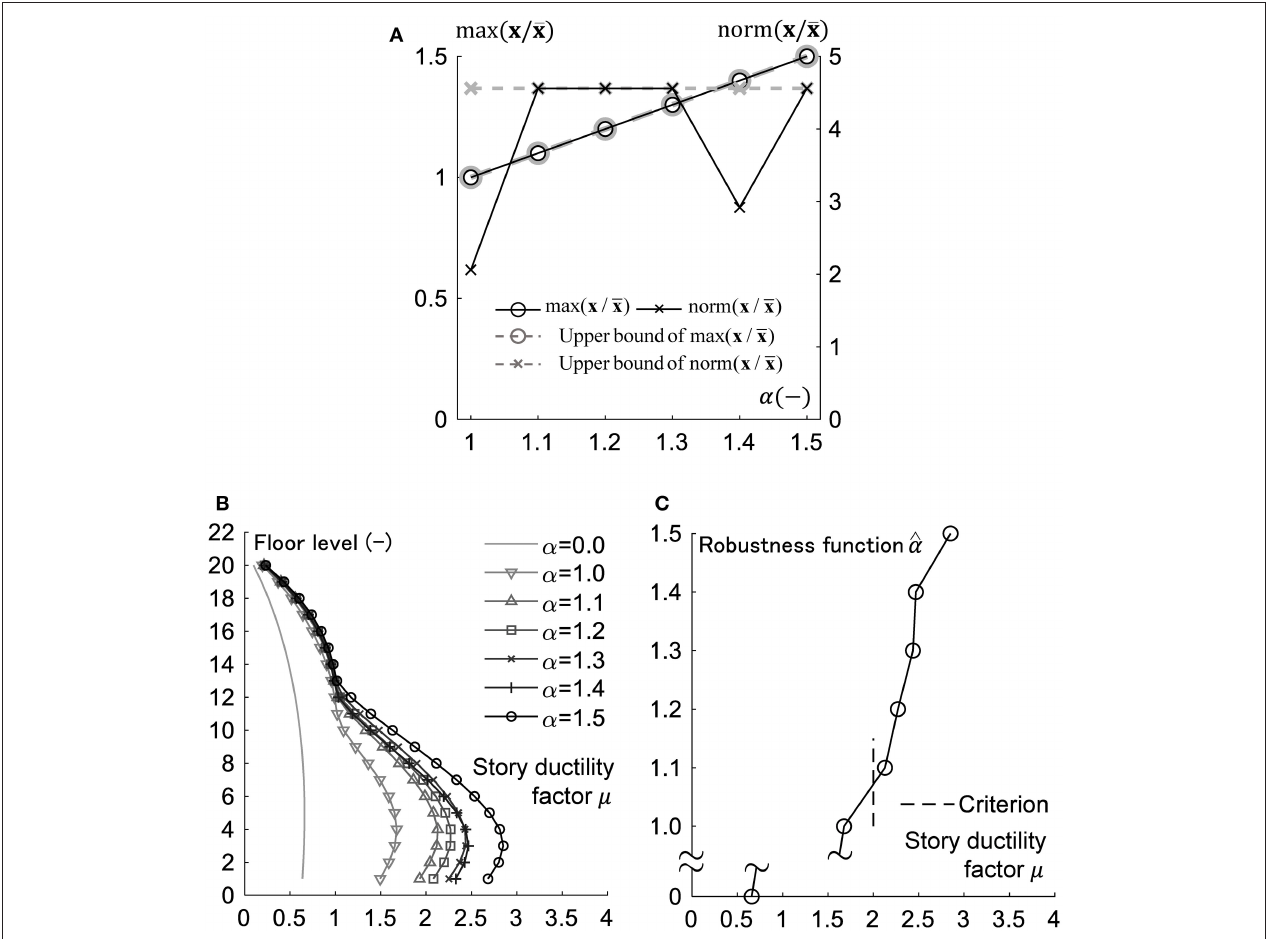
FIGURE 11 | Comparison of responses under several ground motions produced for various uncertainty levels. (A) Maximum value and norm of control point parameter for various uncertainty levels α . (B) Distribution of story ductility factor. (C) Robustness function